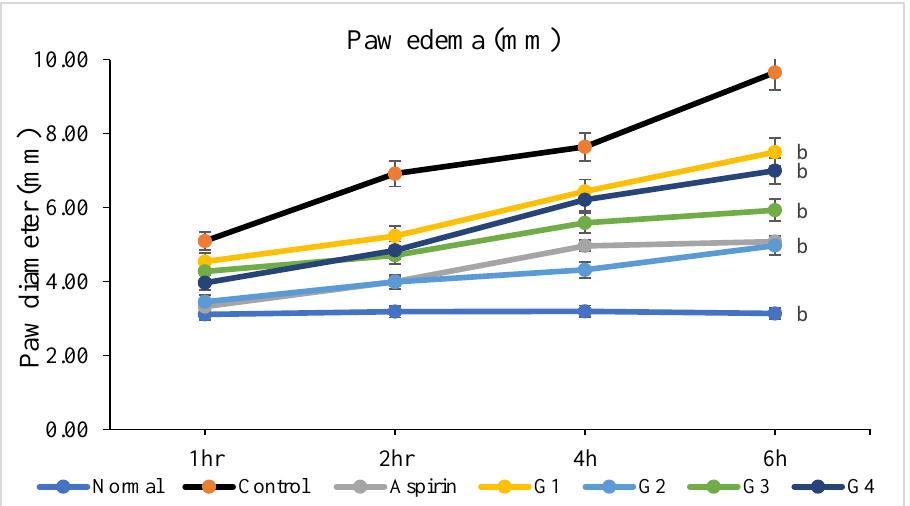
Figure 10. The effect of different treatments on carrageenan-induced paw edema volume at different intervals. All data of the paw edema are represented as mean ± SD. Statistical significance was measured at p < 0.05 based on one-way analysis of variance ANOVA test followed by Tukey’s test for multiple comparisons. b was significantly different from the control group at p < 0.05.